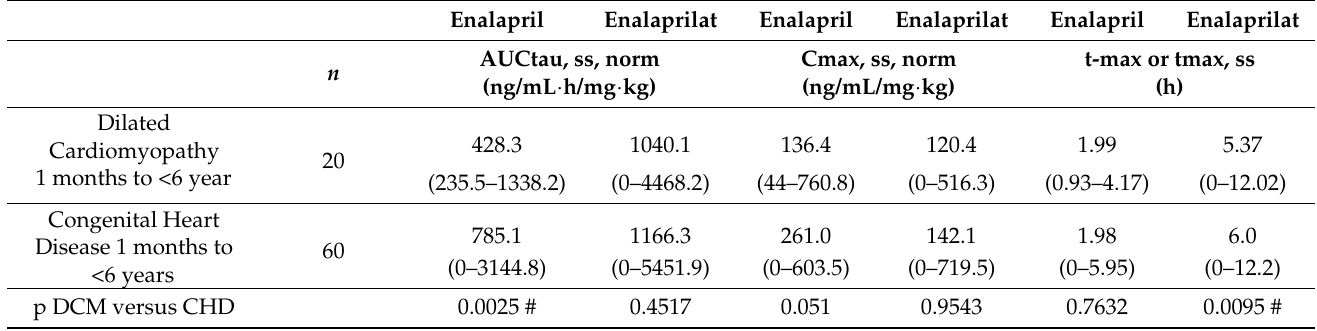
Table 4. Comparison of enalapril and enalaprilat pharmacokinetic parameters in DCM and CHD patients of same age